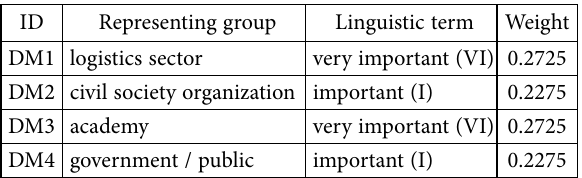
Table 2. Importance of DMs